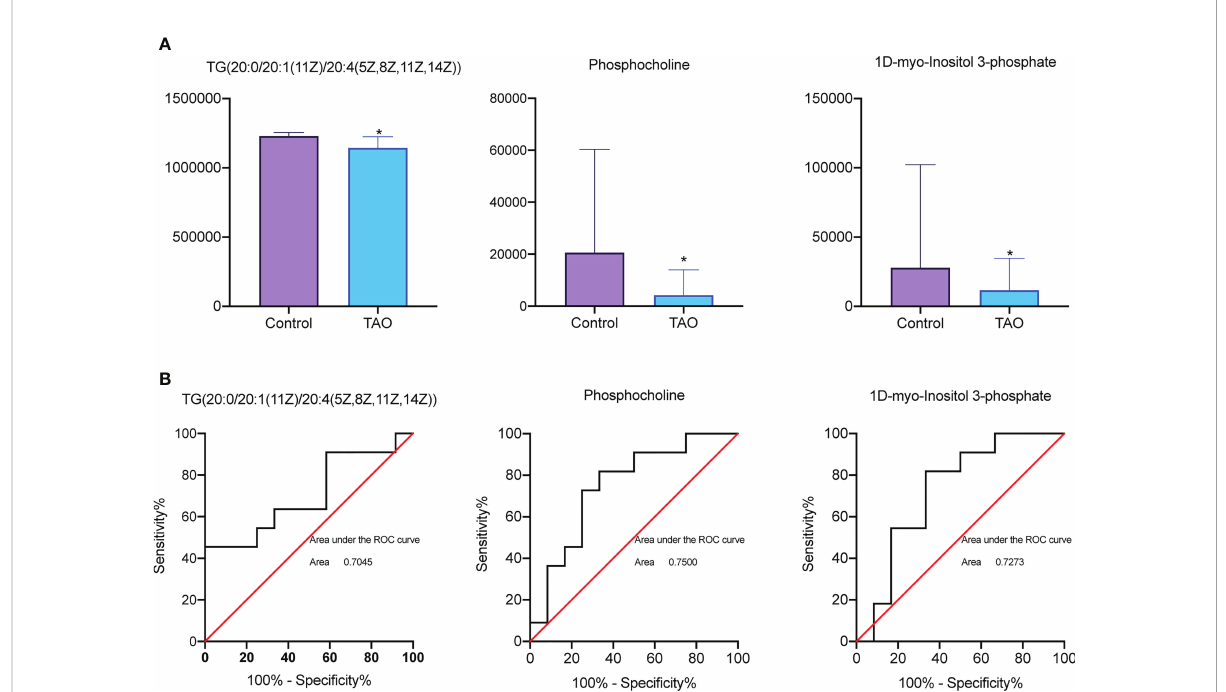
FIGURE 4 Receiver operating characteristic (ROC) curve analysis and bar chart of differential metabolites. (A) Comparison of TG (20:0/20:1(11Z)/20:4 (5Z,8Z,11Z,14Z)), 1D-myo-Inositol 3-phosphate, and phosphocholine level between TAO group and control group (* P < 0.05). (B) ROC curve analysis of TG(20:0/20:1(11Z)/20:4(5Z,8Z,11Z,14Z)), 1D-myo-Inositol 3-phosphate, and phosphocholine in c TAO group and control